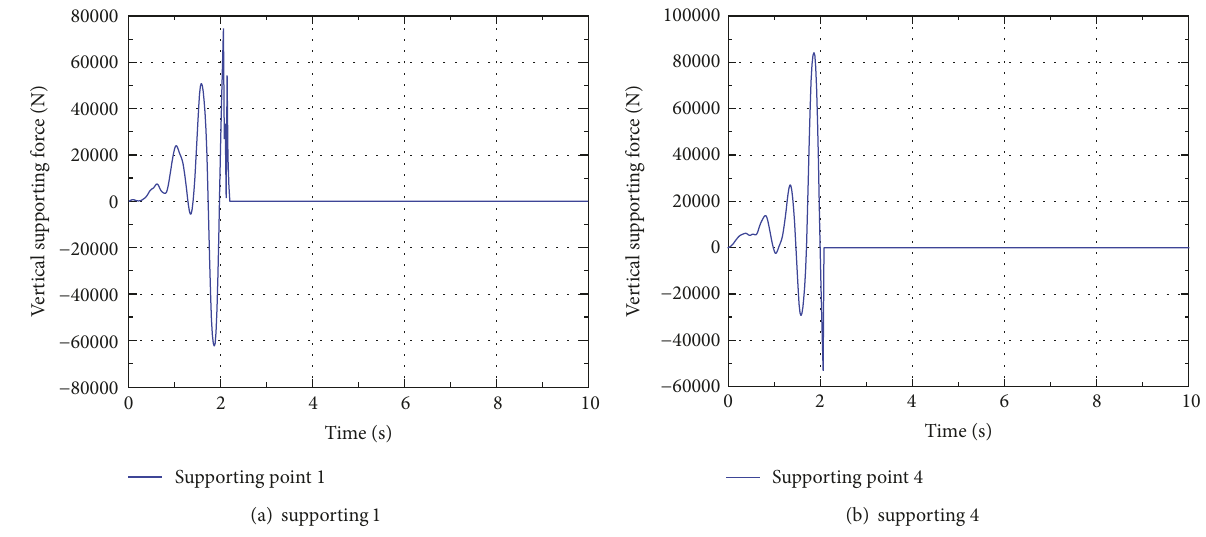
Figure 33: Vertical reaction time history curves for supporting 1 and